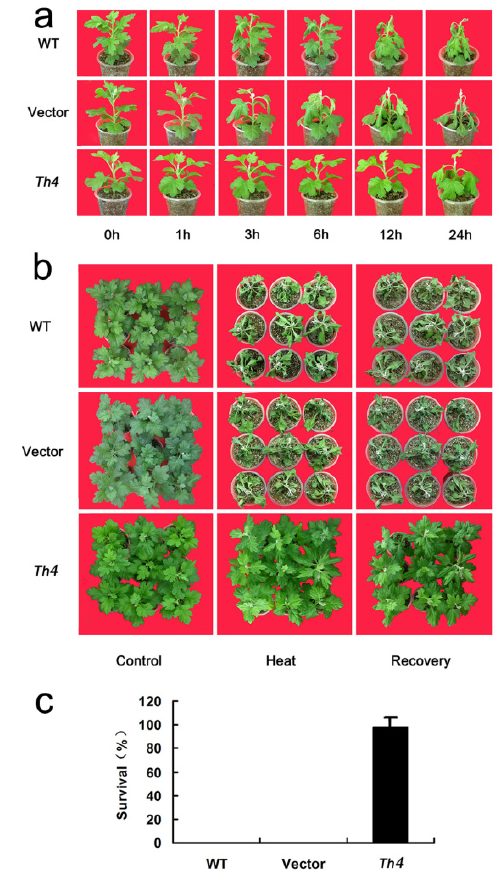
Figure 6. The heat tolerance of transgenic chrysanthemum. ( a ) The appearance of plants (WT, EV and Th4) after exposure to 45 °C for 0–24 h; ( b ) The appearance of plants (WT, EV and Th4) during the recovery phase; ( c ) The survival rate of transgenic and non-transgenic plants exposed to one week of high temperature. Error bars calculated from three